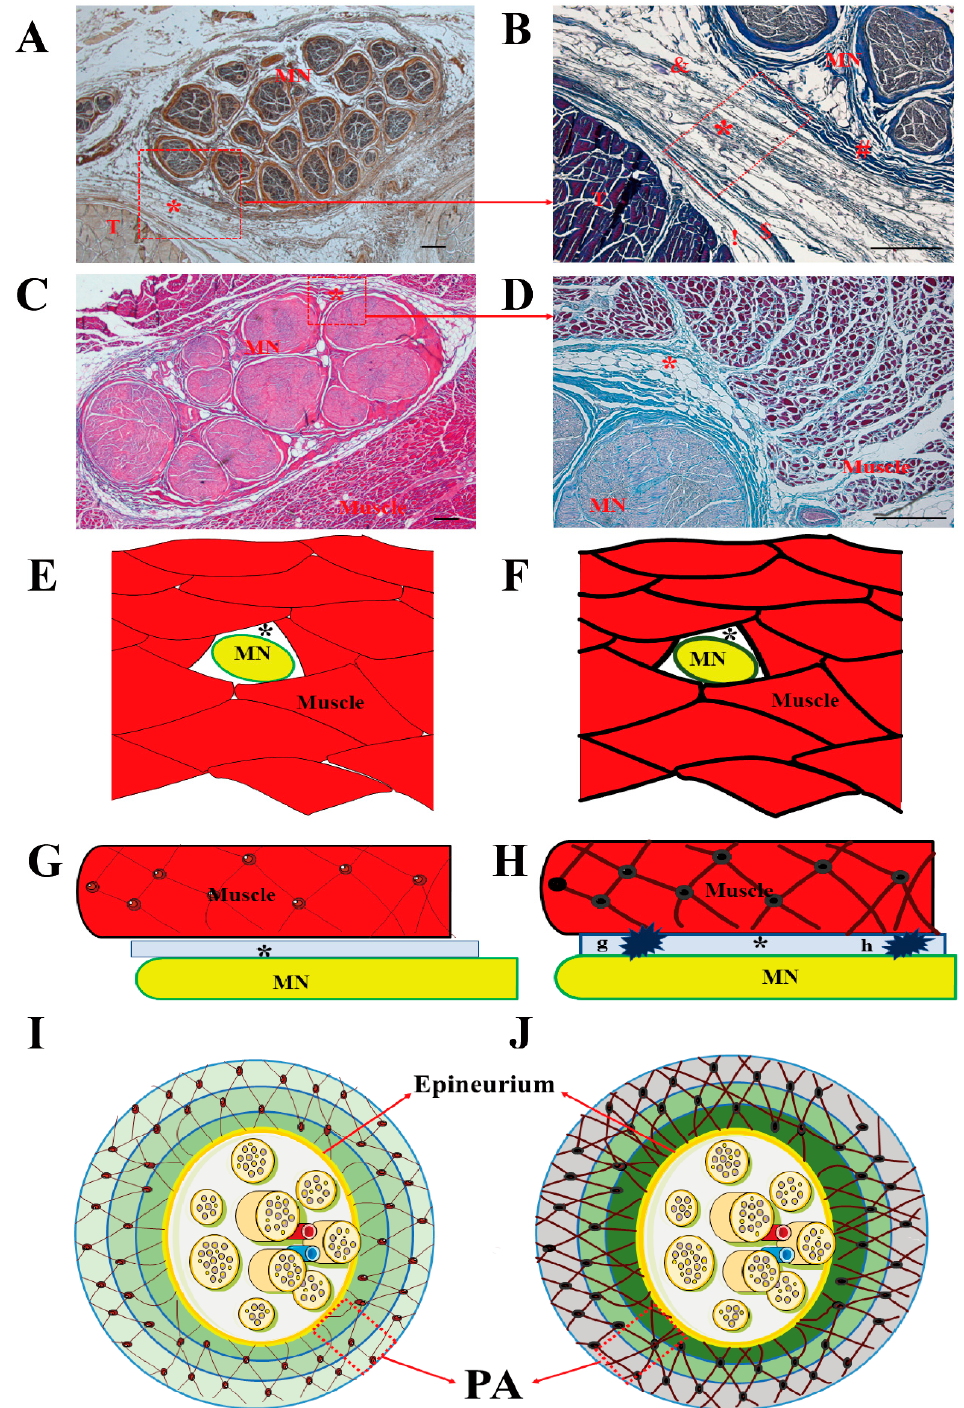
Figure 3. MN and surrounding tissue. Samples stained with S100 antibody ( A ), hematoxylin and eosin ( C ), Azan Mallory Trichrome ( B , D ). E, F, G, H: Sketch of median nerve and myofascial structure in cross ( E , F ) and longitudinal section ( G , H ). Normal myofascial structure in control subjects ( E , G ). Disruption of myofascial structure architecture in CTS ( F , H ). Compression points of MN ( G , H ). Sketch of median nerve and paraneural area (PA) ( I , J ). Normal paraneural area in healthy controls